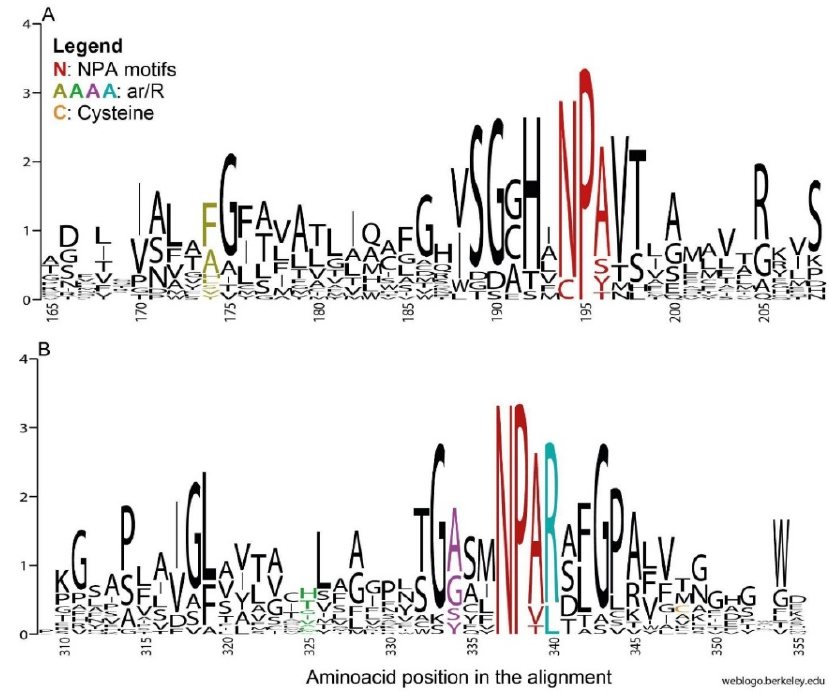
Figure 2. Sequence logos displaying conservation of residues created for all aligned sequences of AQPs (Supplementary Table S3), representing the regions of the first ( A ) and second ( B ) NPA motifs. The y axis represents the probability of the residue occurring at that position. The webserver WebLogo [61] was used.